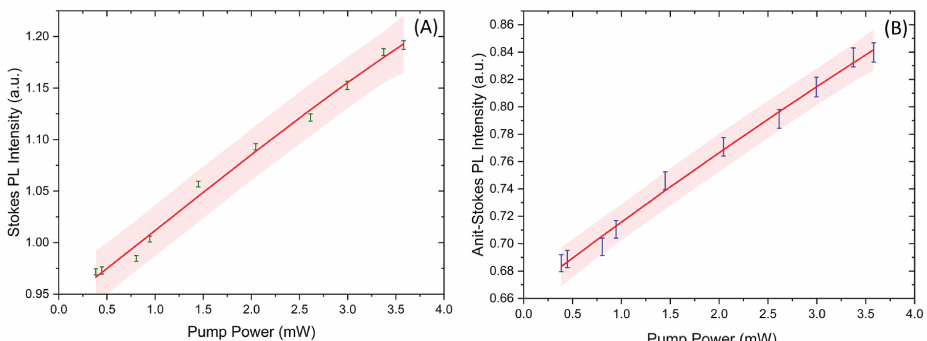
Figure 5. Variation of Stokes ( A ) and anti-Stokes ( B ) Fluorescence intensities of RhB in HFE-7500 fluorocarbon oil in a single phase microflow. The normalized rate of the linear increase in the intensity versus the power of the excitation laser beam for both standard fluorescence and anti-Stokes fluorescence is found to be approximately 0.06